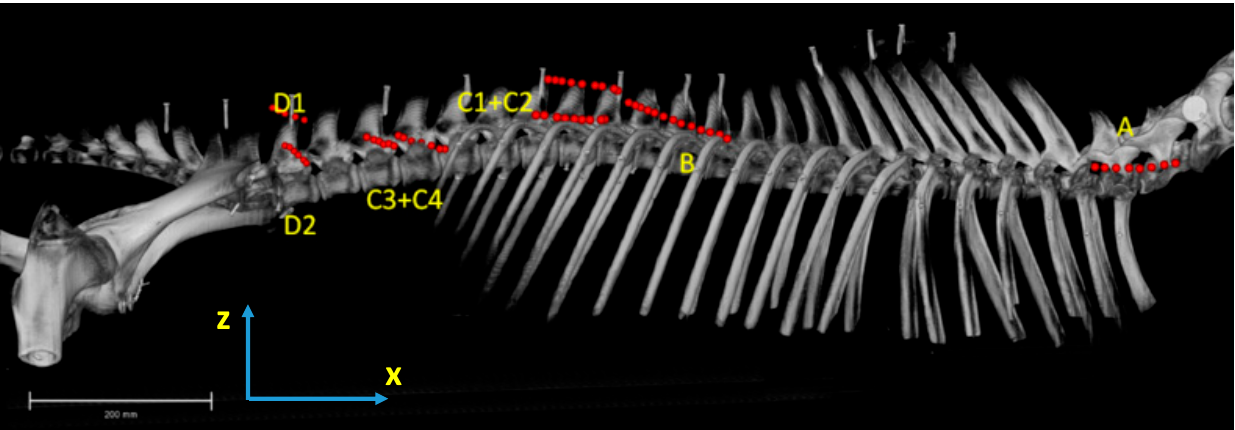
Figure 9. Right lateral view of a rendered CT bone model of a horse back. For each compartment and sub- compartment (indicated with the yellow letters) for the longissimus dorsi muscle, the orientation of one representative fascicle to the horizontal plane is shown in red.